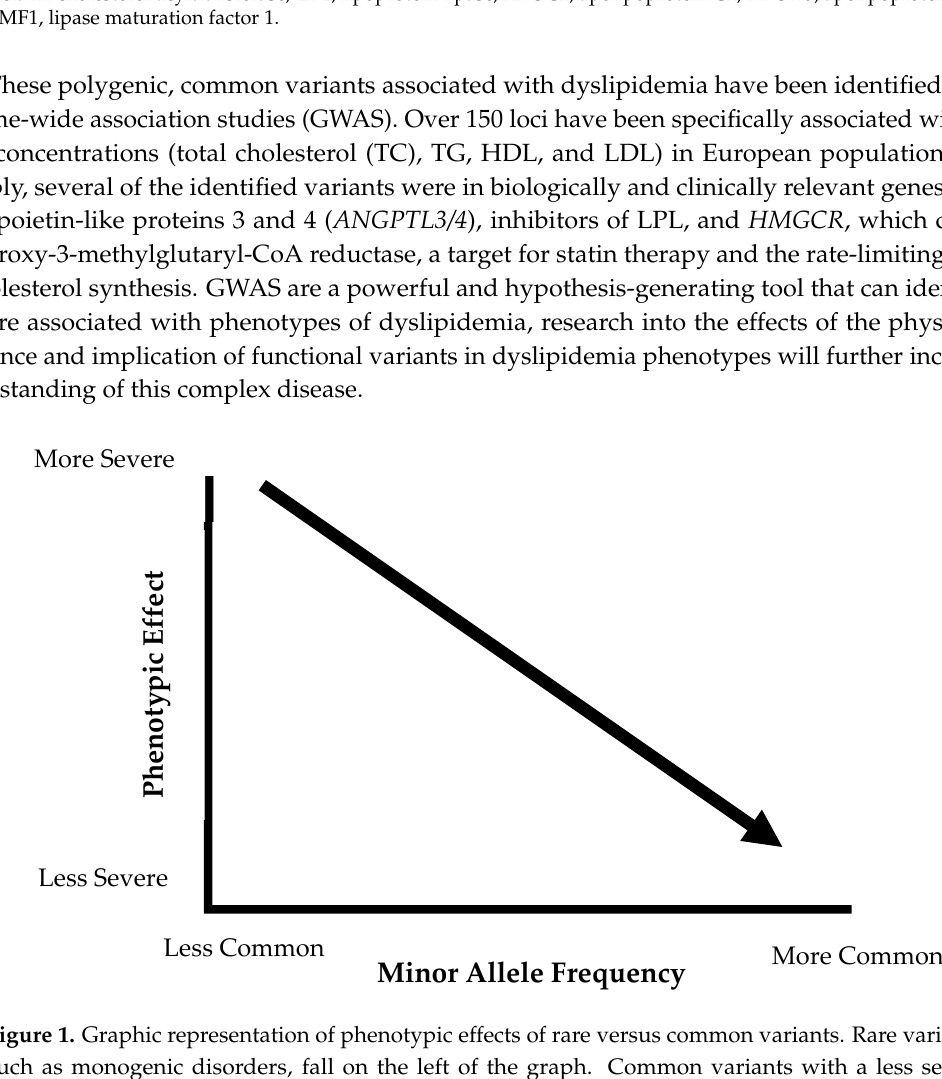
Table adapted from Dron and Hegele [15]. LDL, low-density lipoprotein cholesterol; HDL, high-density lipoprotein cholesterol; TG, triglycerides; LDL-R, LDL receptor; PCSK9, proprotein convertase subtilisin/kexin type 9; APOE, apolipoprotein E; ABCA1, adenosine triphosphate (ATP) binding cassette subfamily A member 1; LCAT, lecithin-cholesterol acyltransferase; LPL, lipoprotein lipase; APOC2, apolipoprotein C2; APOA5, apolipoprotein A5; LMF1, lipase maturation factor 1.